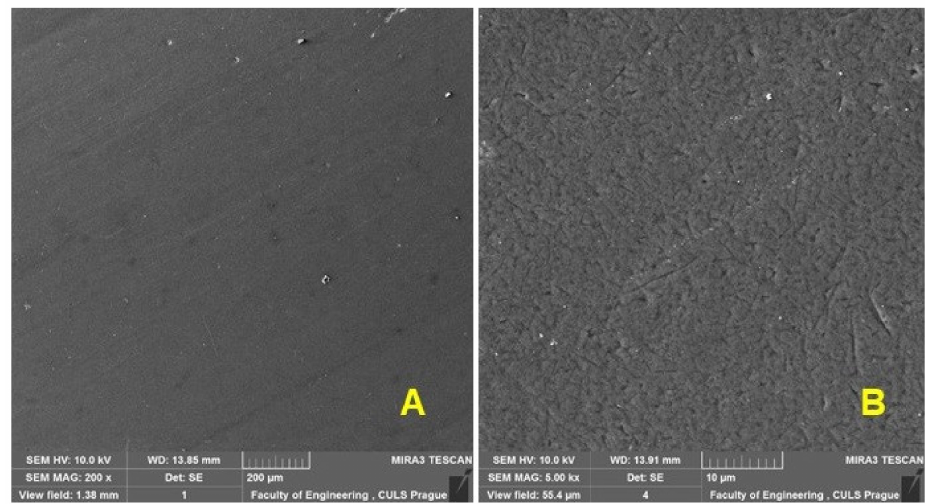
Figure 11. SEM analysis of the surface before wear: ( A ): a macroscopic image of the surface (MAG 200 × ), ( B ): a detailed image (MAG 5.0k × ).